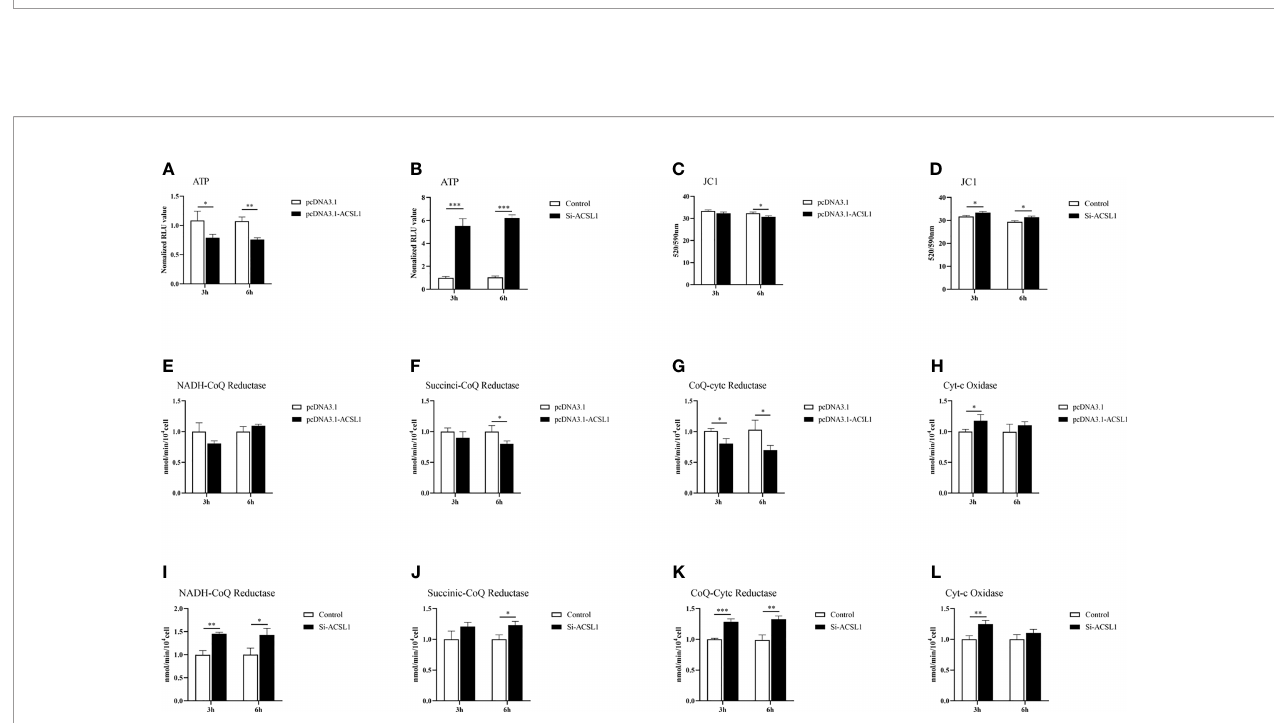
FIGURE 6 | ACSL1 induces MDMs to pro-in fl ammatory phenotypic states. (A, B) The levels of ATP were detected by Enhanced ATP assay kit. (C – D) The levels of mitochondrial membrane potential JC1 were detected by Enhanced mitochondrial membrane potential assay kit with JC-1. (E – L) Mitochondrial respiratory chain complexes activity detection kit was used to analyze mitochondrial respiratory chain enzyme activities. Data shown are the means±SEM (n=3). P values were calculated using two-tailed unpaired Student ’ s t-test. Differences with P<0.05 were considered signi fi cant. *P < 0.05, **P < 0.01, ***P <